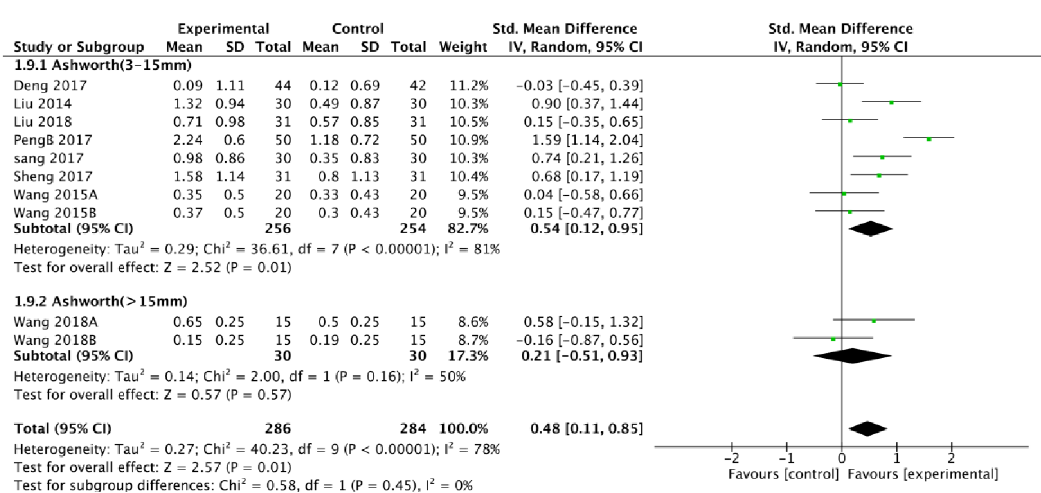
Fig 8. Meta-analysis of fire acupuncture versus acupuncture for spasticity after stoke according to depth of acupuncture in MAS.